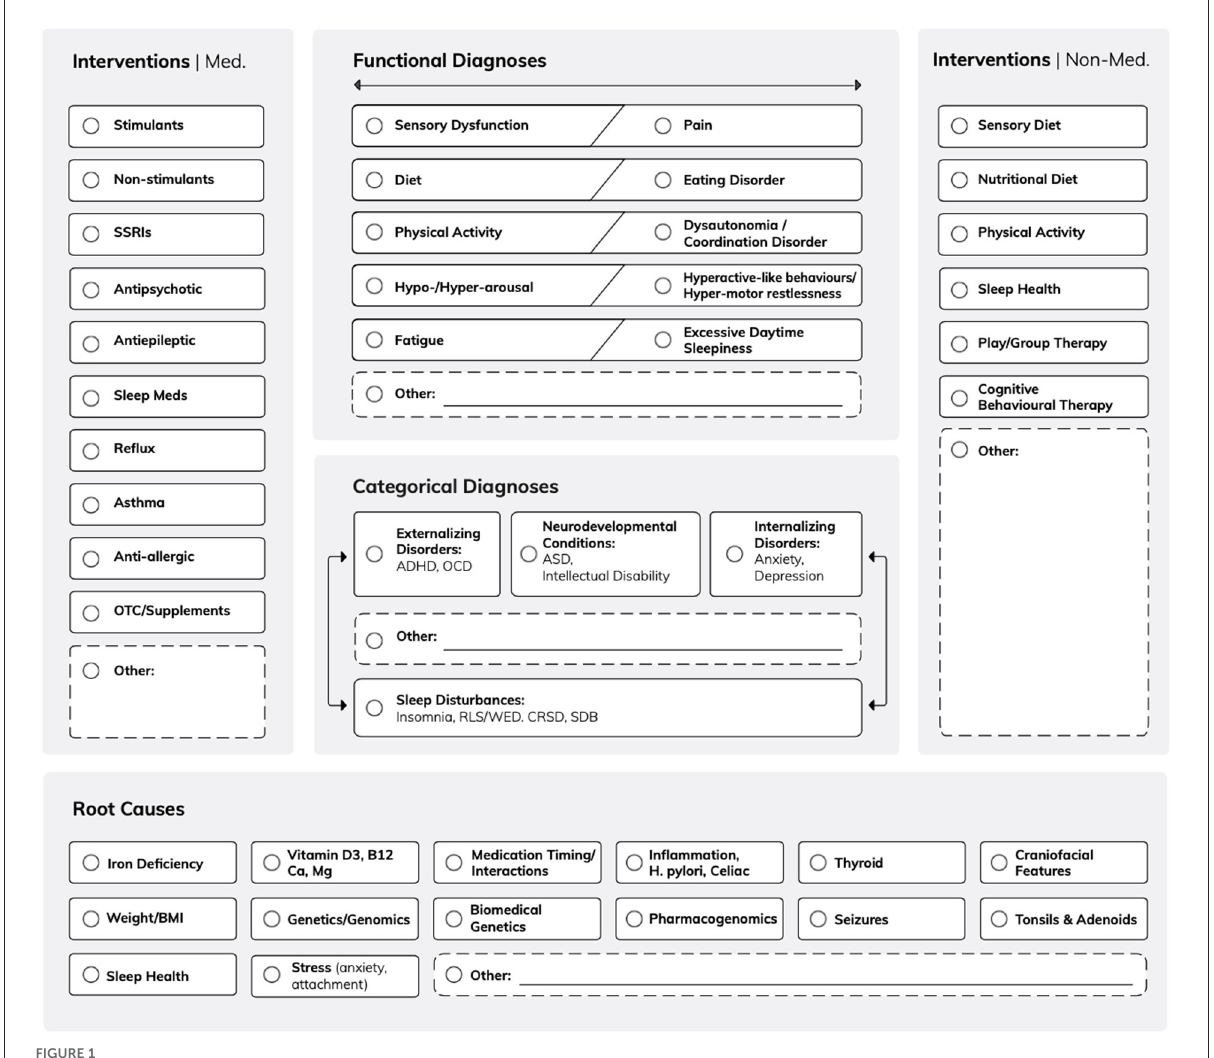
FIGURE1 The Mind the Gap Logic Model. Exploring the interplay between functional and categorical diagnoses and the influence of root causes on medical and non-medical interventions. The model underscores the importance of sleep disturbances and their bidirectional influence with other categorical diagnoses such as internalizing/externalizing disorders and neurodevelopmental conditions. Root causes including iron and vitamin deficiency and sleep health offer an innovative approach to complement conventional medical and non-medical IDD